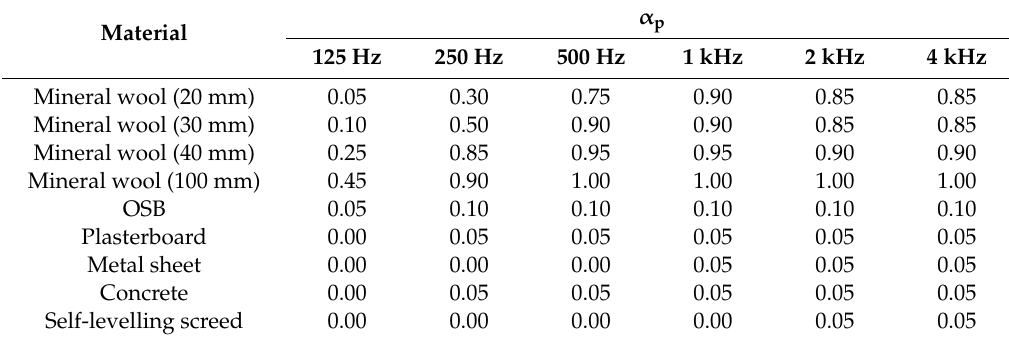
Table 1. Sound absorption coefficients, α p , of used materials, in octave bands.